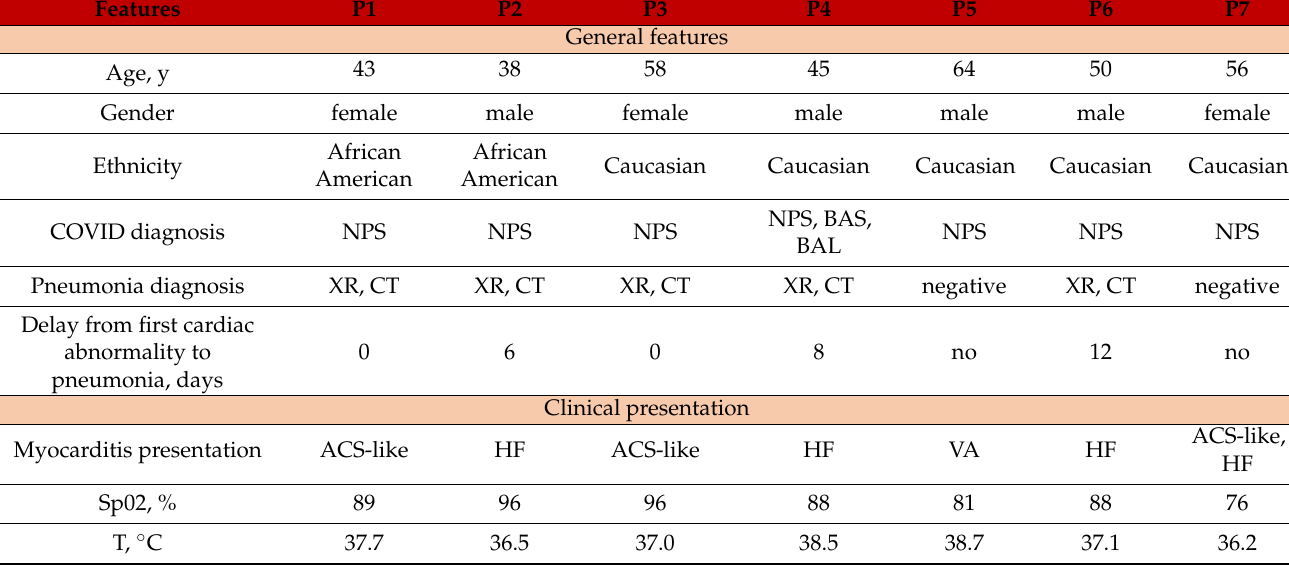
Table 1. Baseline features and diagnostic